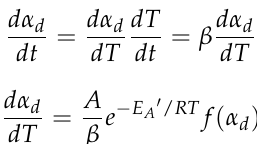
Figure 5. The predicted time–temperature profile of the Ag-filled ICA when T g = 100 °C.